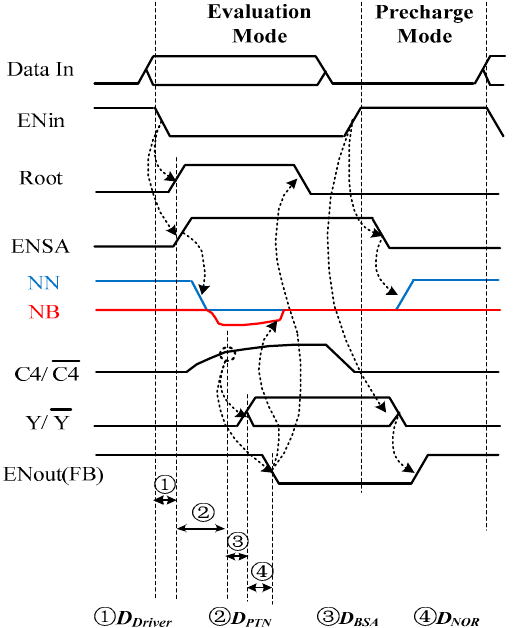
Figure 5. The timing diagram of the bootstrapped SAPTL.